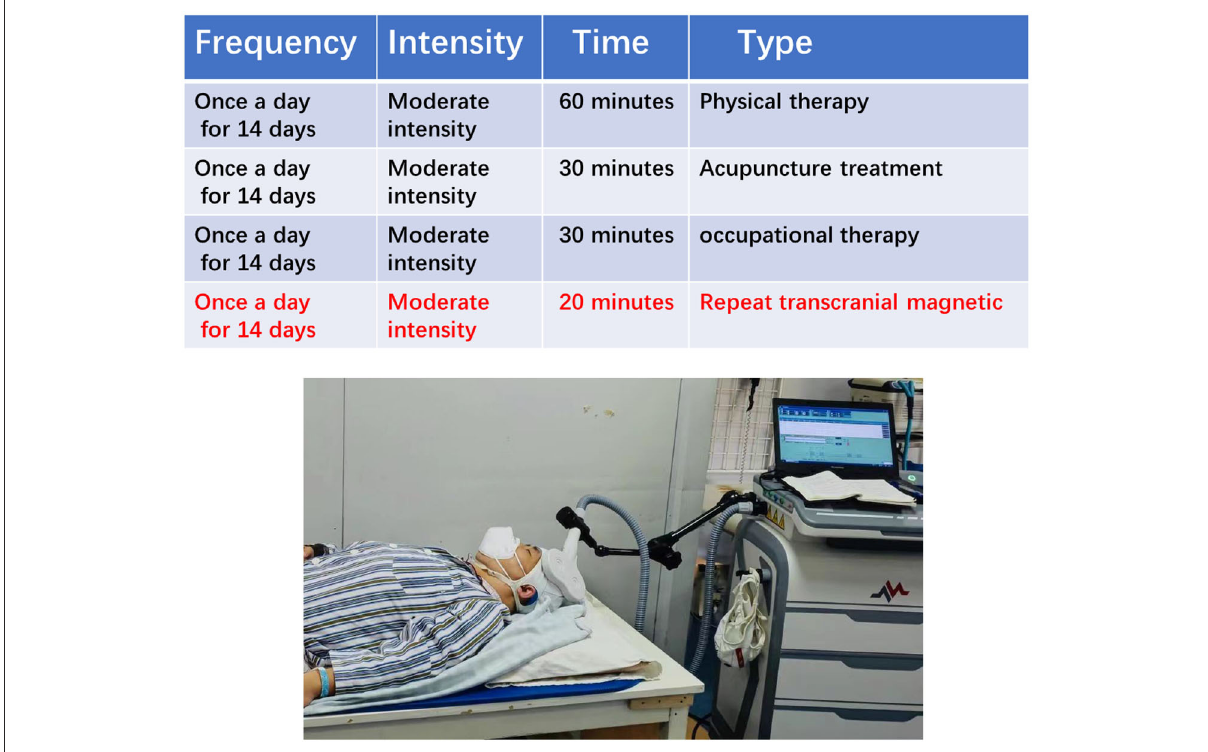
FIGURE4 A patient undergoing repeat transcranial magnetic therapy.